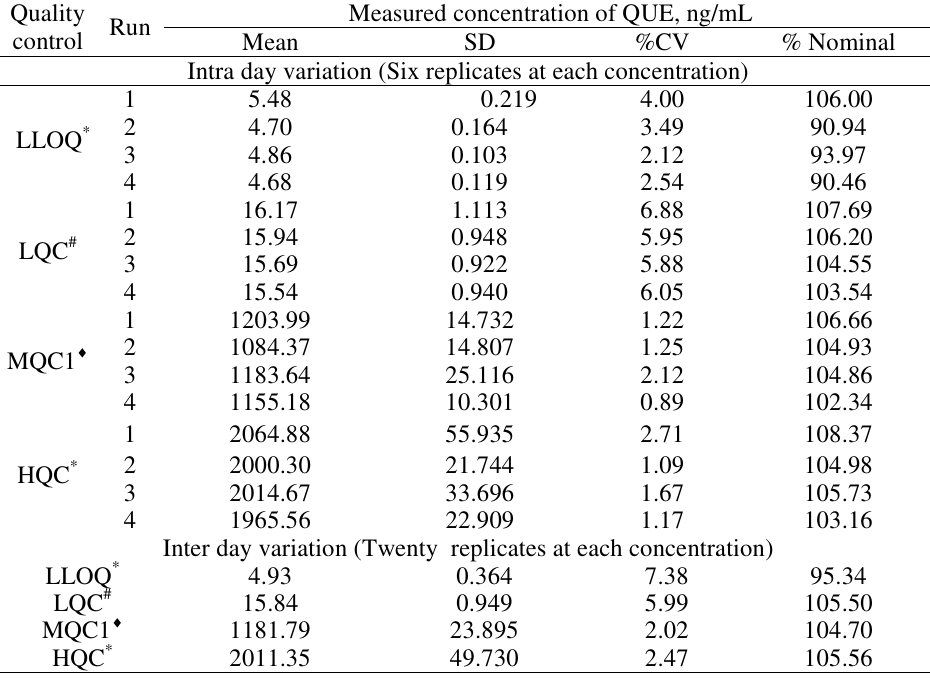
Table 2. Intra- and inter-day precision of determination of QUE in human plasma